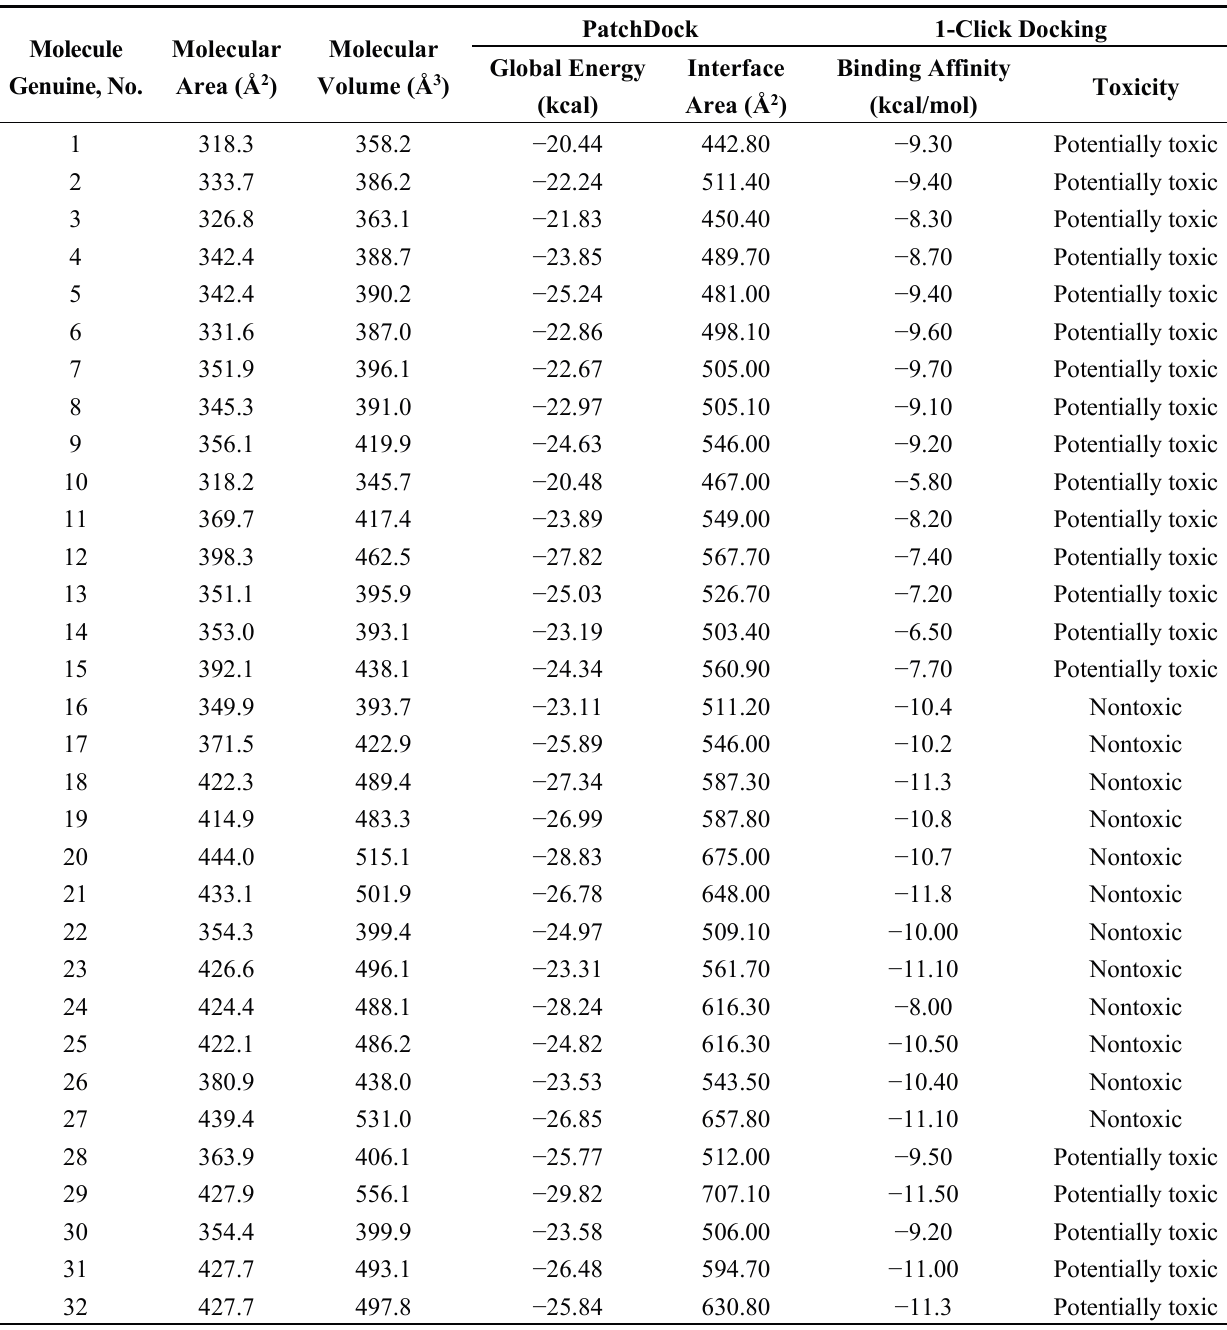
Table 2. Results for the genuine molecules of Table 1 in terms of molecular surface and volume, docking algorithms as PatchDock and 1-Click Docking with the reported global energy and interface area—for the first approach and with the binding affinity and toxicity for the second one,